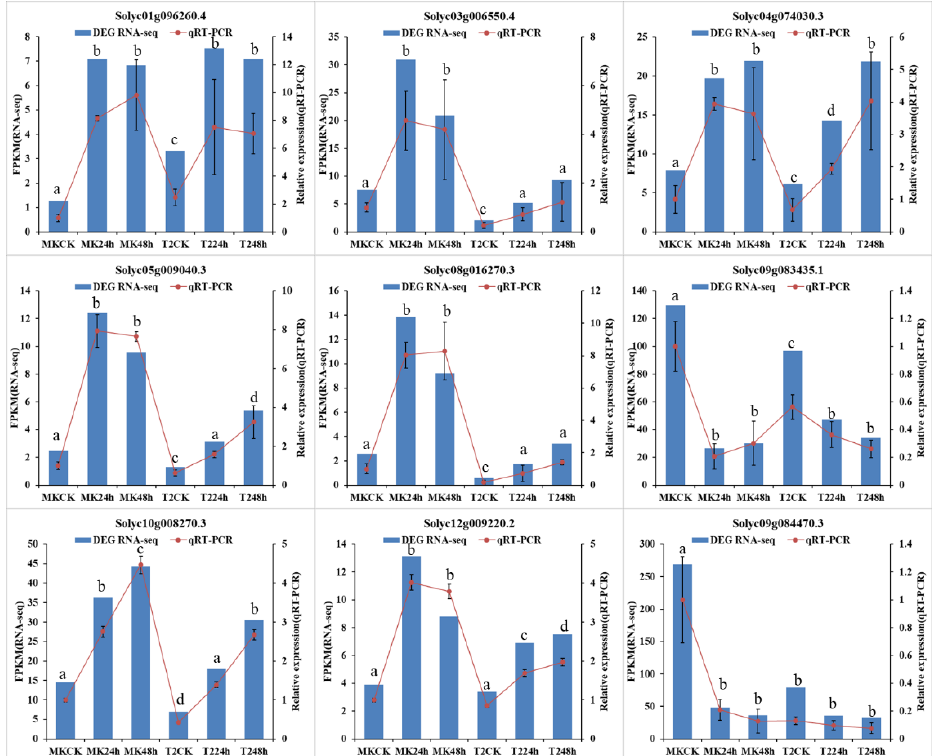
Figure 7. Verification of nine randomly selected DEGs by qRT-PCR. Comparison of RNA-seq data (blue bar) with qRT-PCR data (red line). The normalized expression level (FPKM) of RNA-seq is indicated on the Y-axis to the left, and the relative qRT-PCR expression level is shown on the Y-axis to the right. α -Tubulin (Solyc04g077020.2) was used as the internal control. Both methods show similar gene expression trends. Three biological replicates were performed. Data were analyzed by an ANOVA in the SPSS software, and a, b, c, and d indicate statistically significant differences ( p < 0.05) for the designated time point.